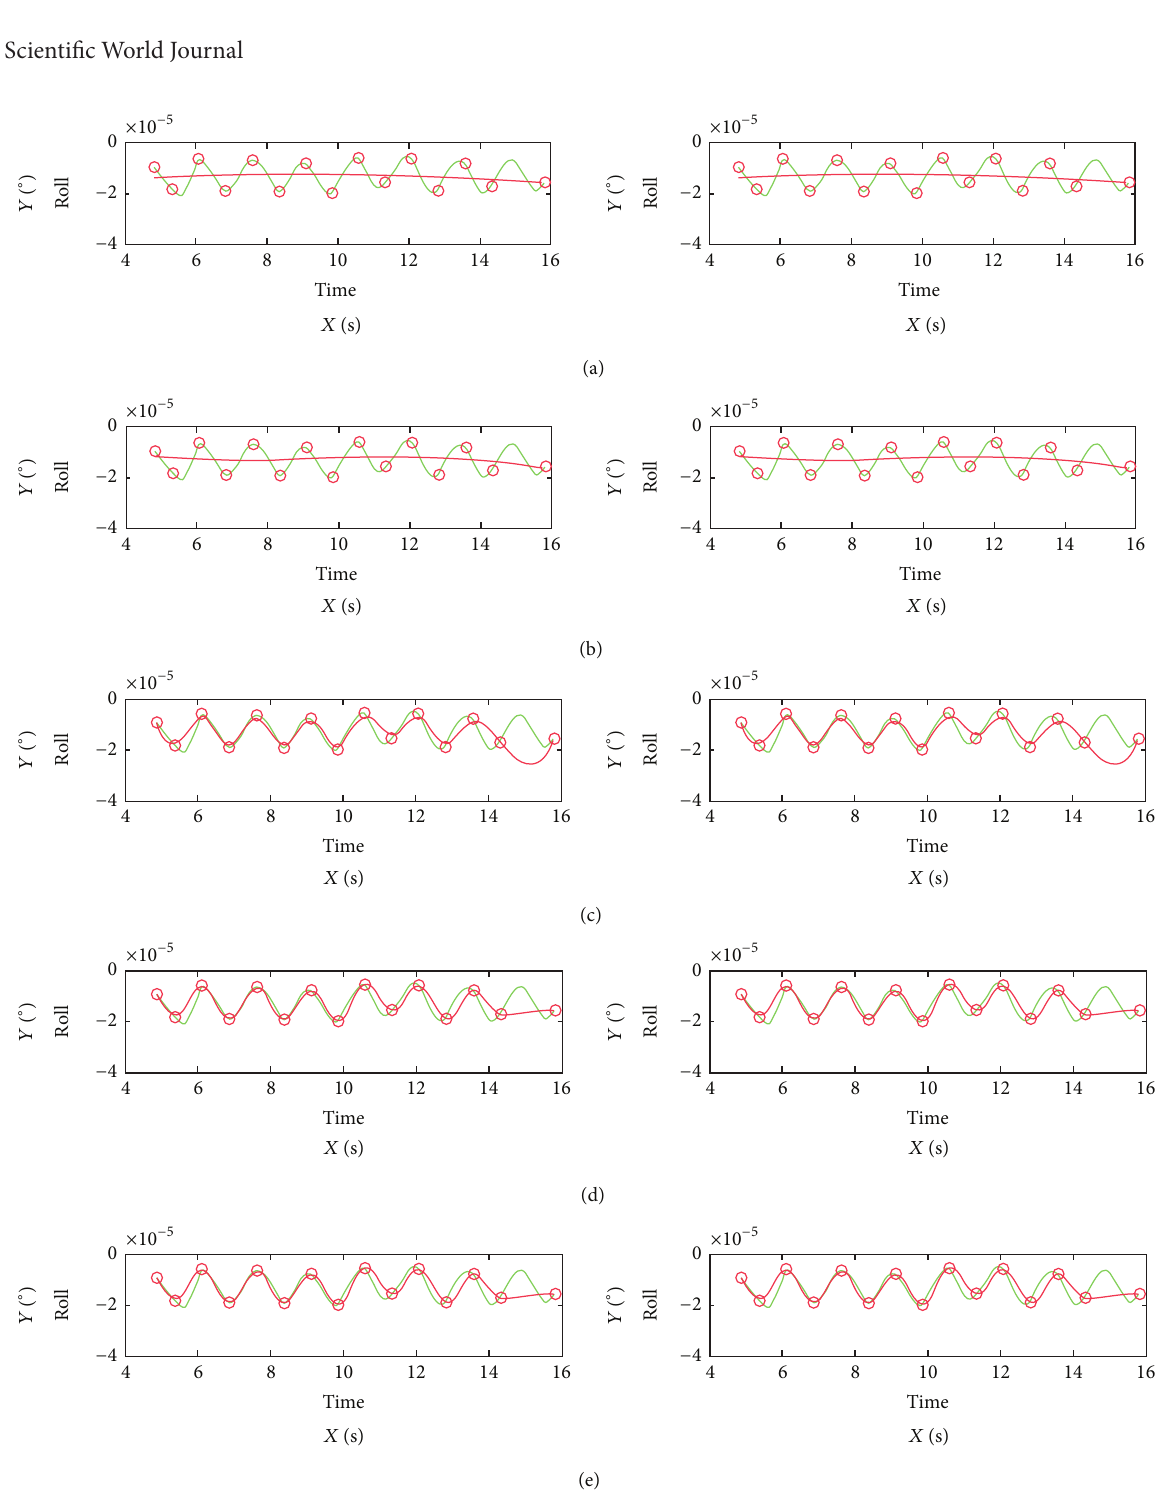
Figure 6: The fitting curves with the different trajectory